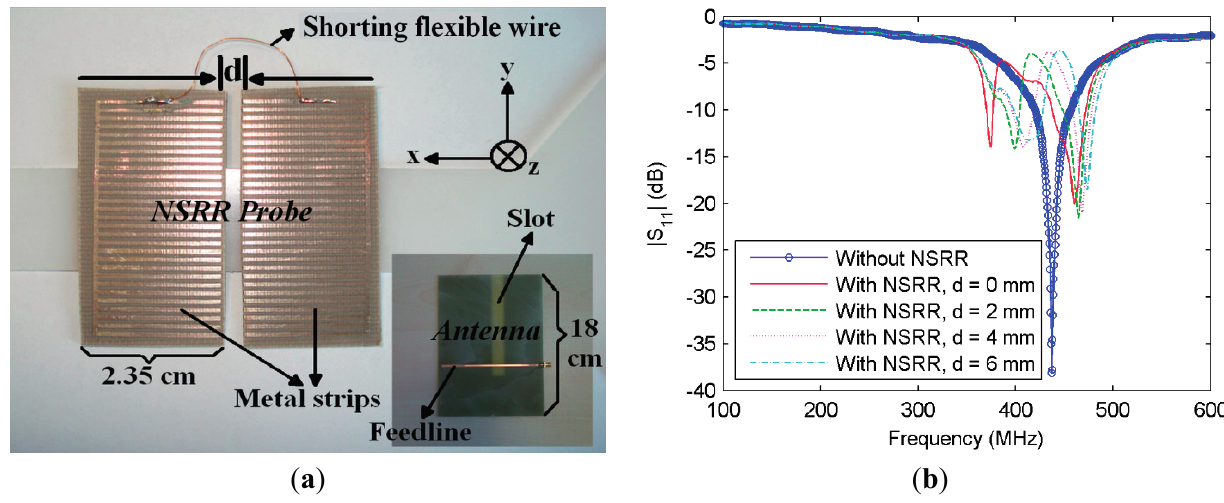
Figure 1. ( a ) Comb-like nested split ring resonator (NSRR) probe geometry separated into two symmetrical parts, which are electrically connected by a long flexible wire. The microstrip single slot antenna is shown at the right bottom (inset); ( b ) Experimental |S 11 | data plotted for the cases when the NSRR is not present in front of the antenna (only the antenna resonance is present) and when the NSRR sensor is present with displacement d = 0, 2, 4 and 6 mm, respectively.